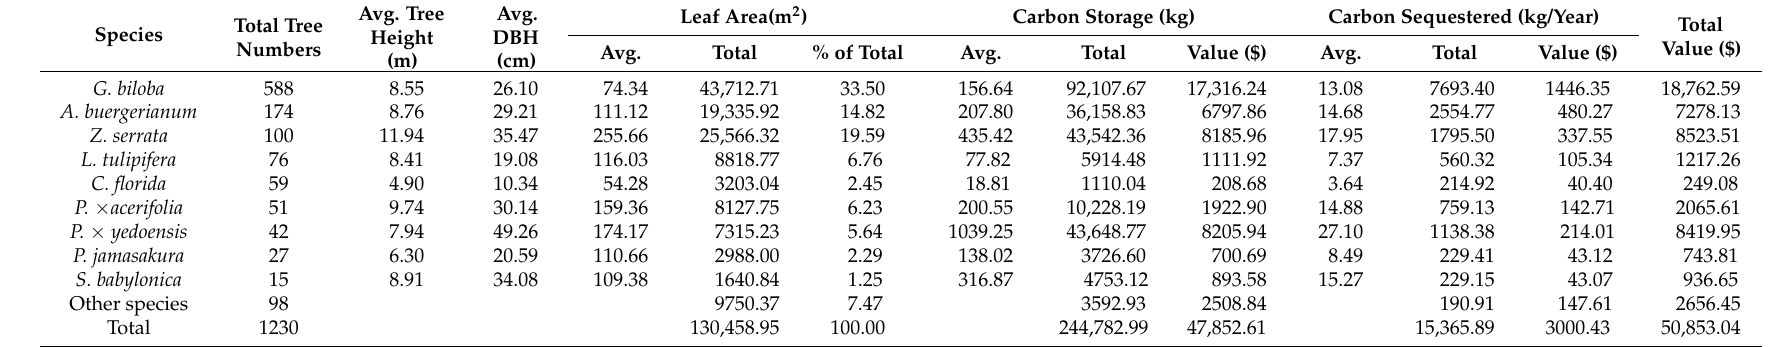
Table 2. Predominant street tree species and their annual carbon storage and sequestration values in Kyoto